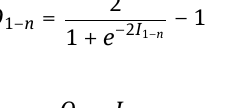
Figure 5: Performance of the network testing 2 shown in MSE